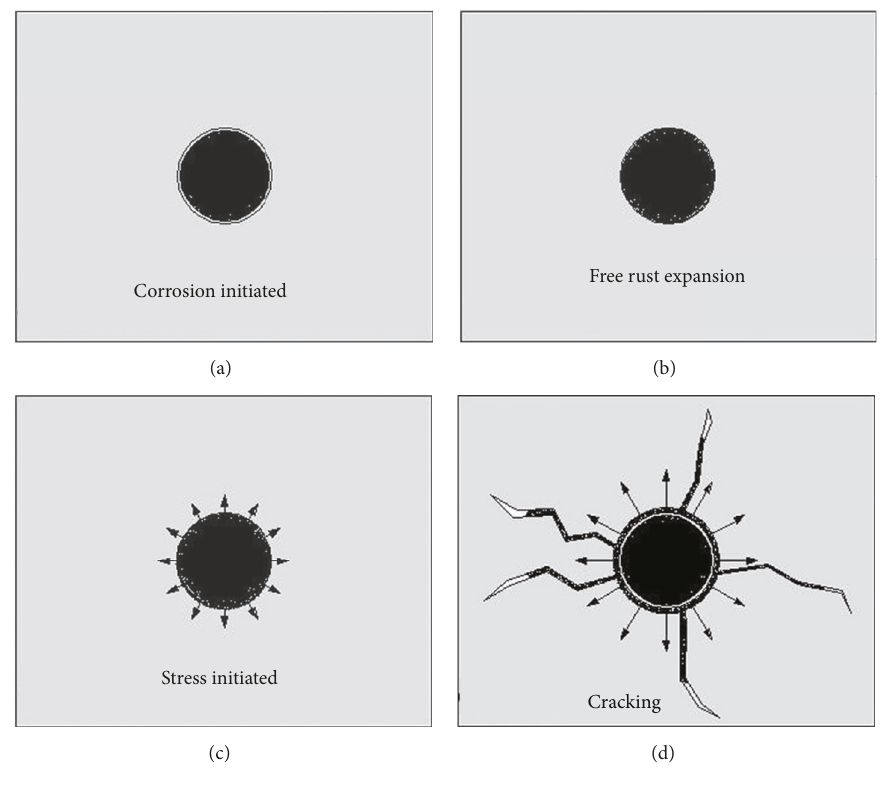
Figure 8: (a–d) Illustration of the corrosion process [12].